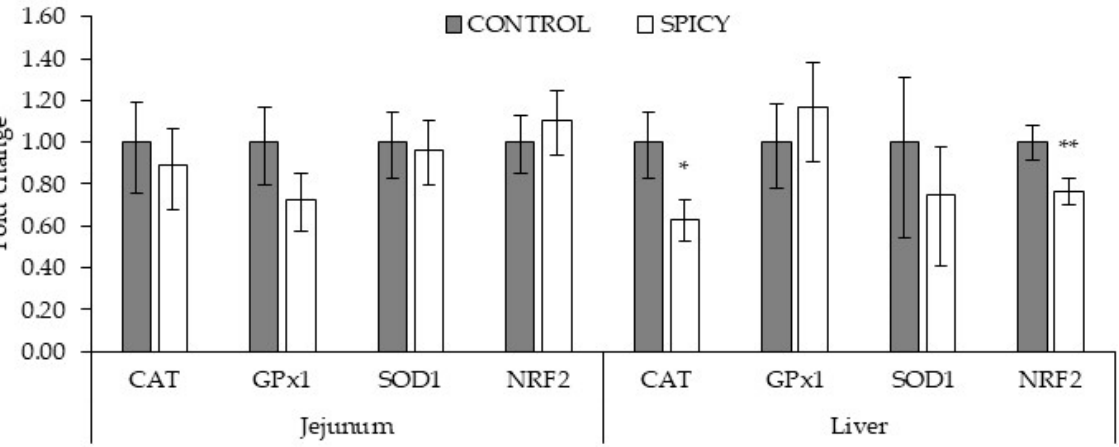
Figure 1. Effect of experimental diets on broiler chicken jejunum and liver gene expression at 21 d of age. CAT, catalase; GPx1, glutathione peroxidase 1; SOD1, superoxide dismutase 1; Nrf2, nuclear factor erythroid 2-related factor 2. Gene expression values are indicated as fold changes relative to the mRNA levels in CONTROL set to be 1.0. Bars indicate the 95% confidence interval (fold change up-fold change low) ( n = 12; *: p < 0.05; **: p < 0.01).